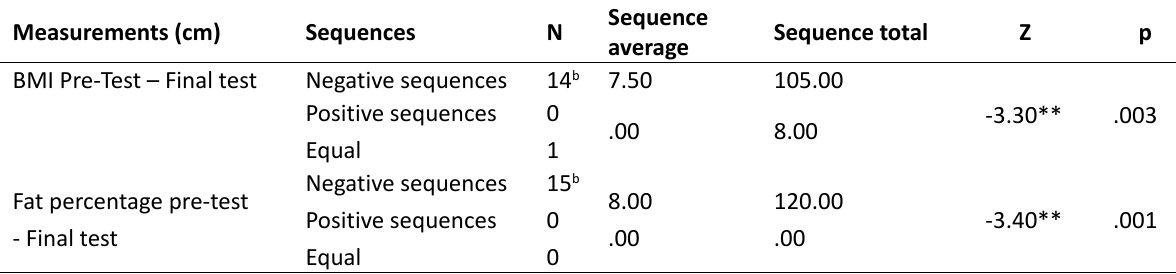
**p<0.01 Table 4. Wilcoxon test results in the BMI and fat percentage parameters of the women Measurements